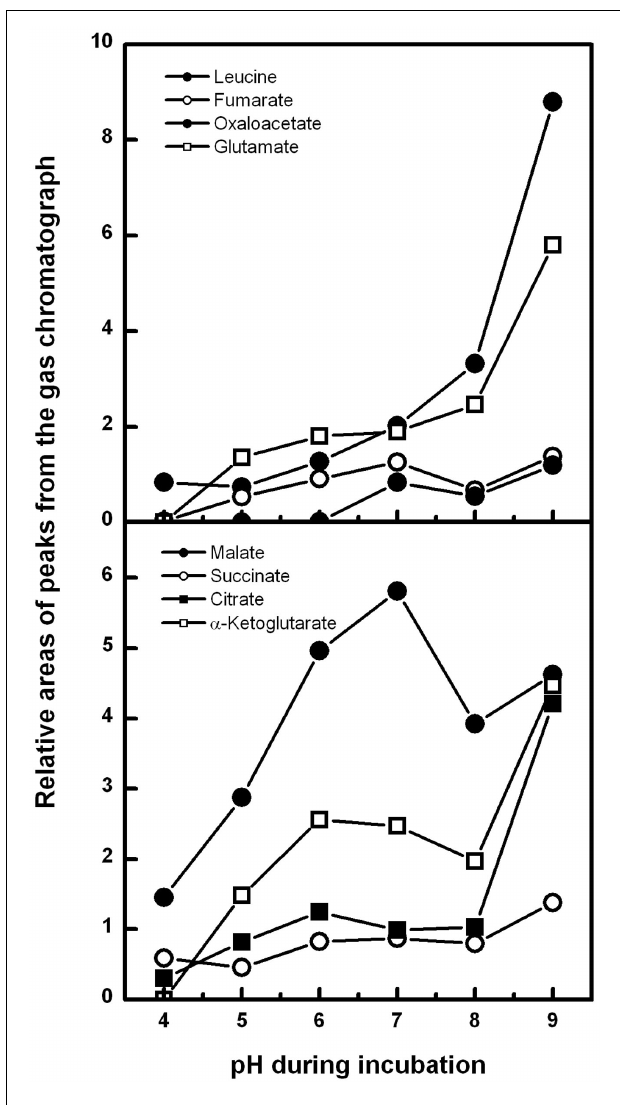
FIGURE 1 | Organic acid excretion of non-growing hyphae of Neurospora crassa in response to different ambient pH. Hyphae (average length ∼ 300 μ m) were grown in shaking flasks cultures, harvested, washed, and transferred to a pH-stat at 25˚C (resuspension solution 10mM KCl, 1% glucose).The culture broth was immediately titrated to a defined pH between 4 and 9. Samples were taken after 40min and analyzed via gas chromatography.The amount of excreted organic acid anions roughly matched the calculated H + -release. Methods and data derived from Slayman et al. (1990), Rivetta et al. (2011), and unpublished results from C. L Slayman and P. Kaminski (redrawn and modified with kind